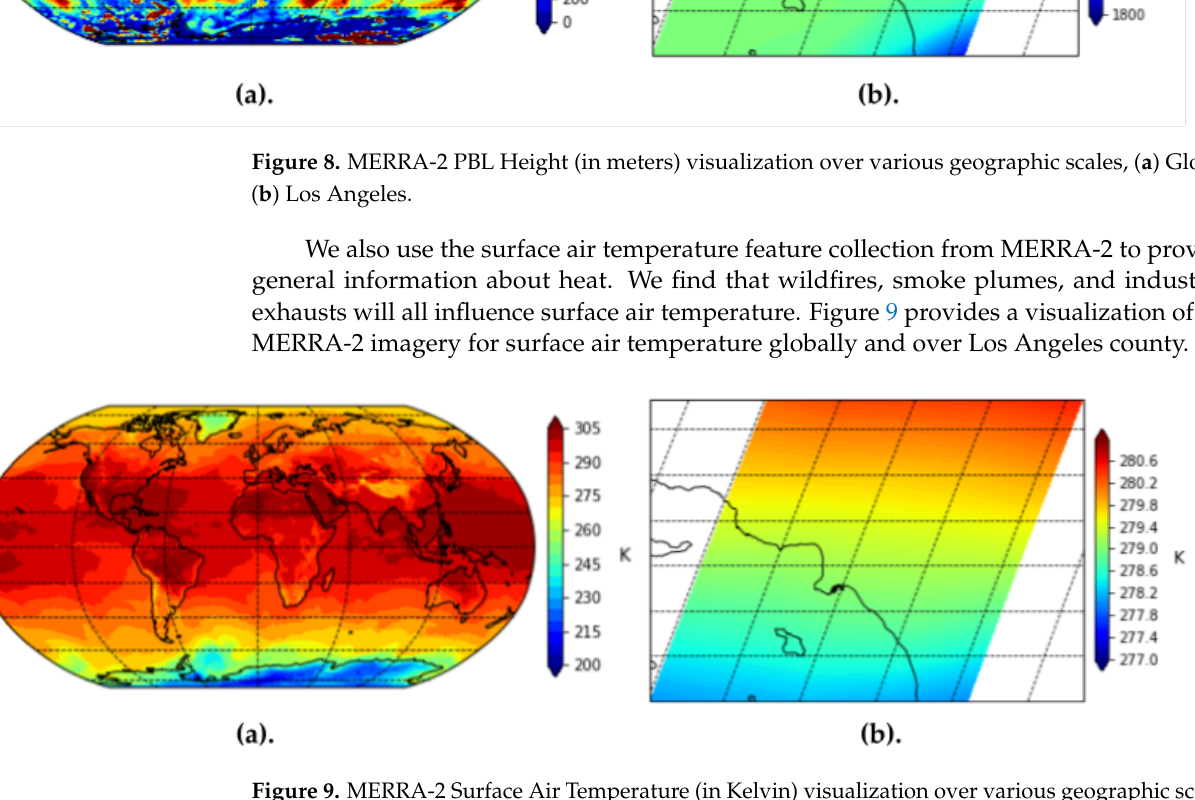
Figure 9. MERRA-2 Surface Air Temperature (in Kelvin) visualization over various geographic scales, ( a ) Global, ( b ) Los